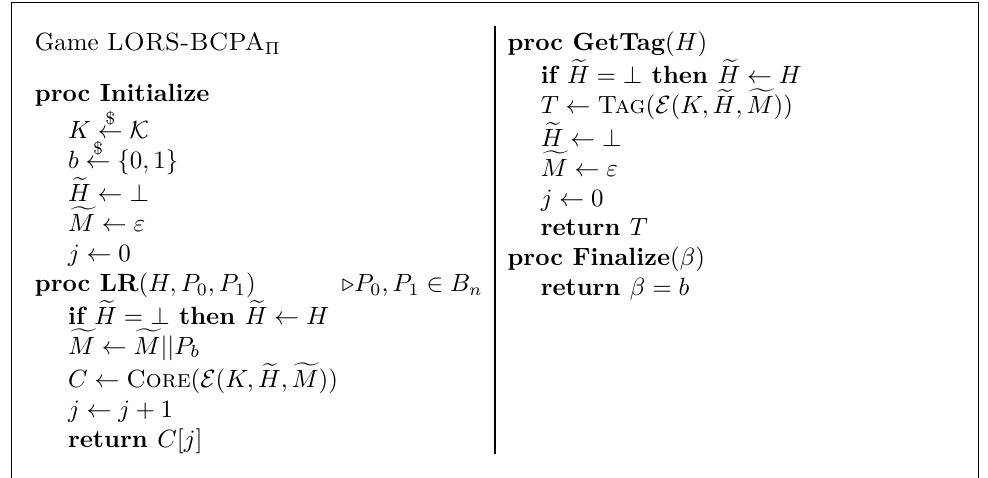
Figure 5: Game LORS-BCPA Π used to define blockwise